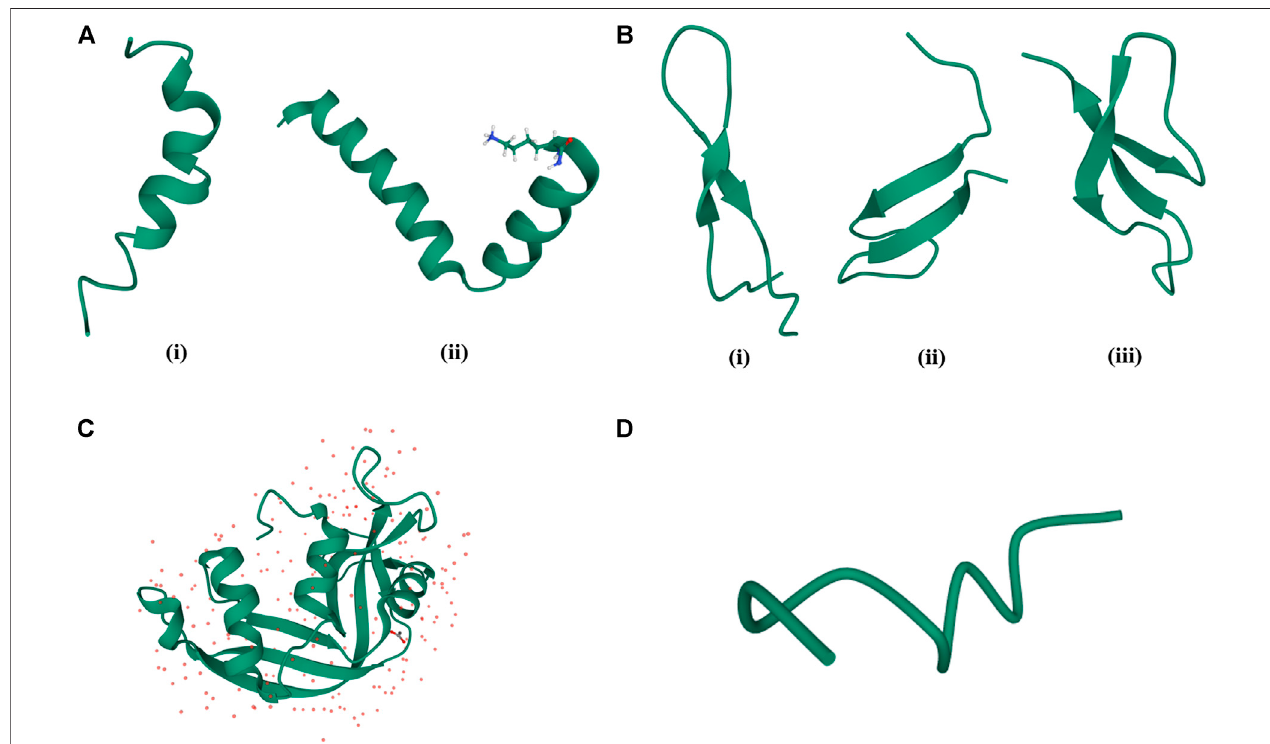
FIGURE 1 | Classi fi cation of AMPs based on their structures. (A) α -helical AMPs: (i) Magainin (PDB code — 2LSA), (ii) Cecropin (PDB code — 2LA2). (B) β -sheet AMPs: (i) Bovine Lactoferrin (PDB code — 1LFC), (ii) Hepcidin (PDB code — 2KEF), (iii) Rabbit Kidney Defensins (PDB code — 1EWS). (C) α -helix, β -sheet mixed AMPs: RNase 2 (PDB code — 1GQV). (D) Random coil structure of AMPs: Cys deleted protein (PDB code — 2MQ5).